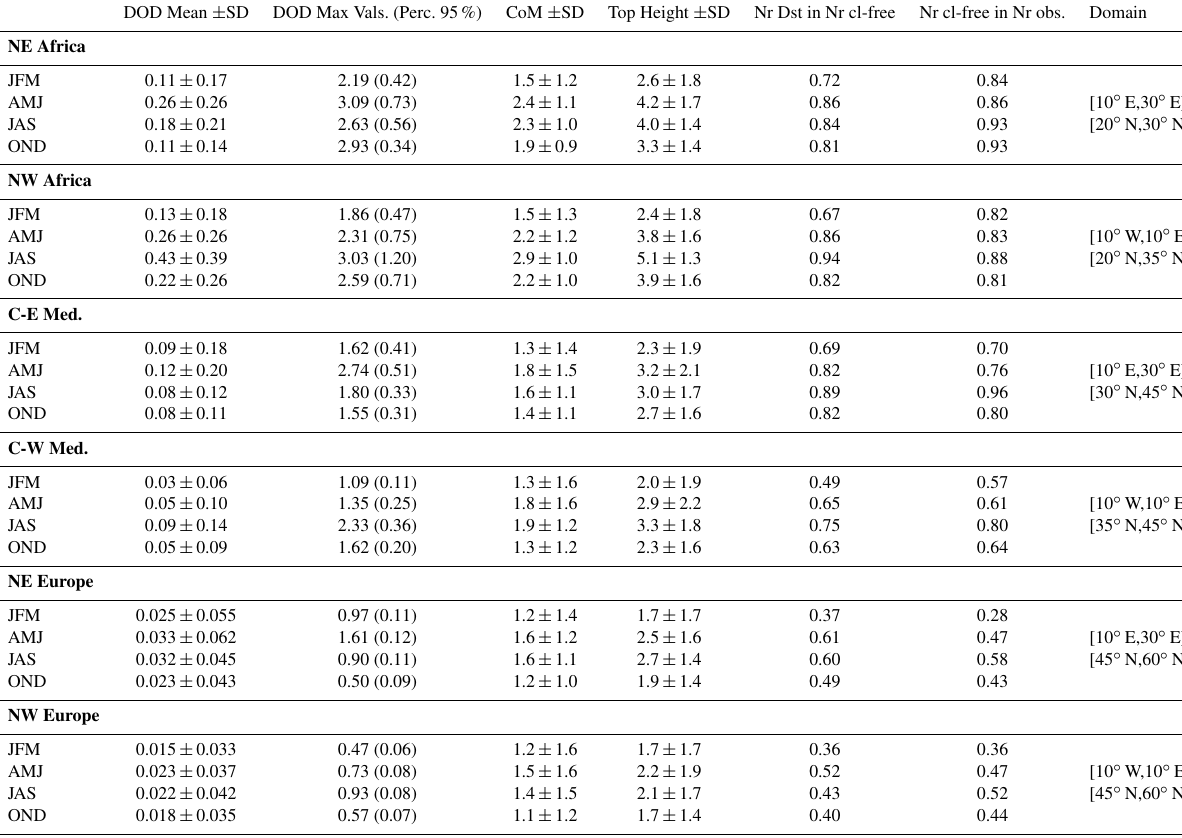
Table 2. Regional statistics on mean dust optical depth, max values, dust layer center of mass (CoM) and top height (TH) (a.s.l.), ratio of dust observations to cloud-free observations, ratio of cloud-free observations to total observations and domain